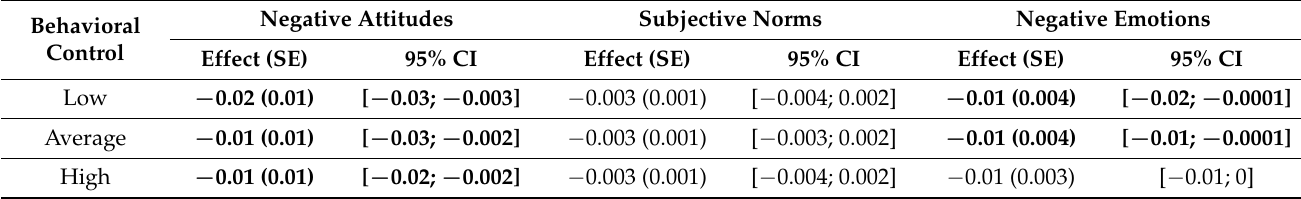
Table 4. Indices of conditional moderated mediation for levels of behavioral